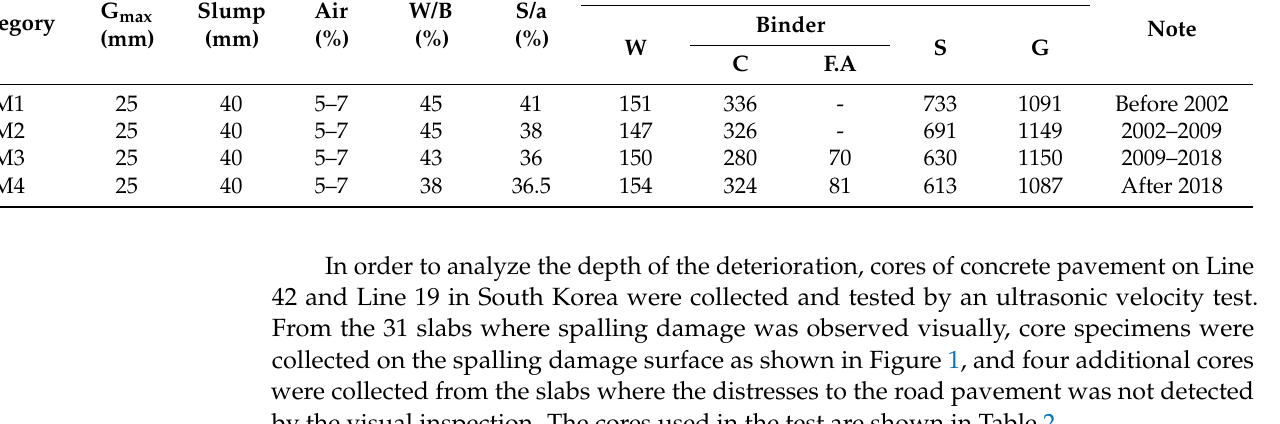
Table 1. Concrete pavement mixing ratio based on quality of expressway pavement materials in South Korea.